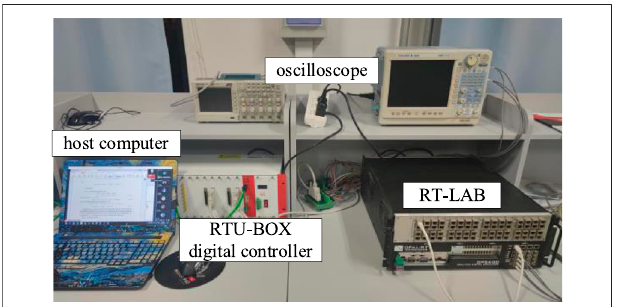
FIGURE 8 | Hardware-in-the-loop real-time simulation experimental